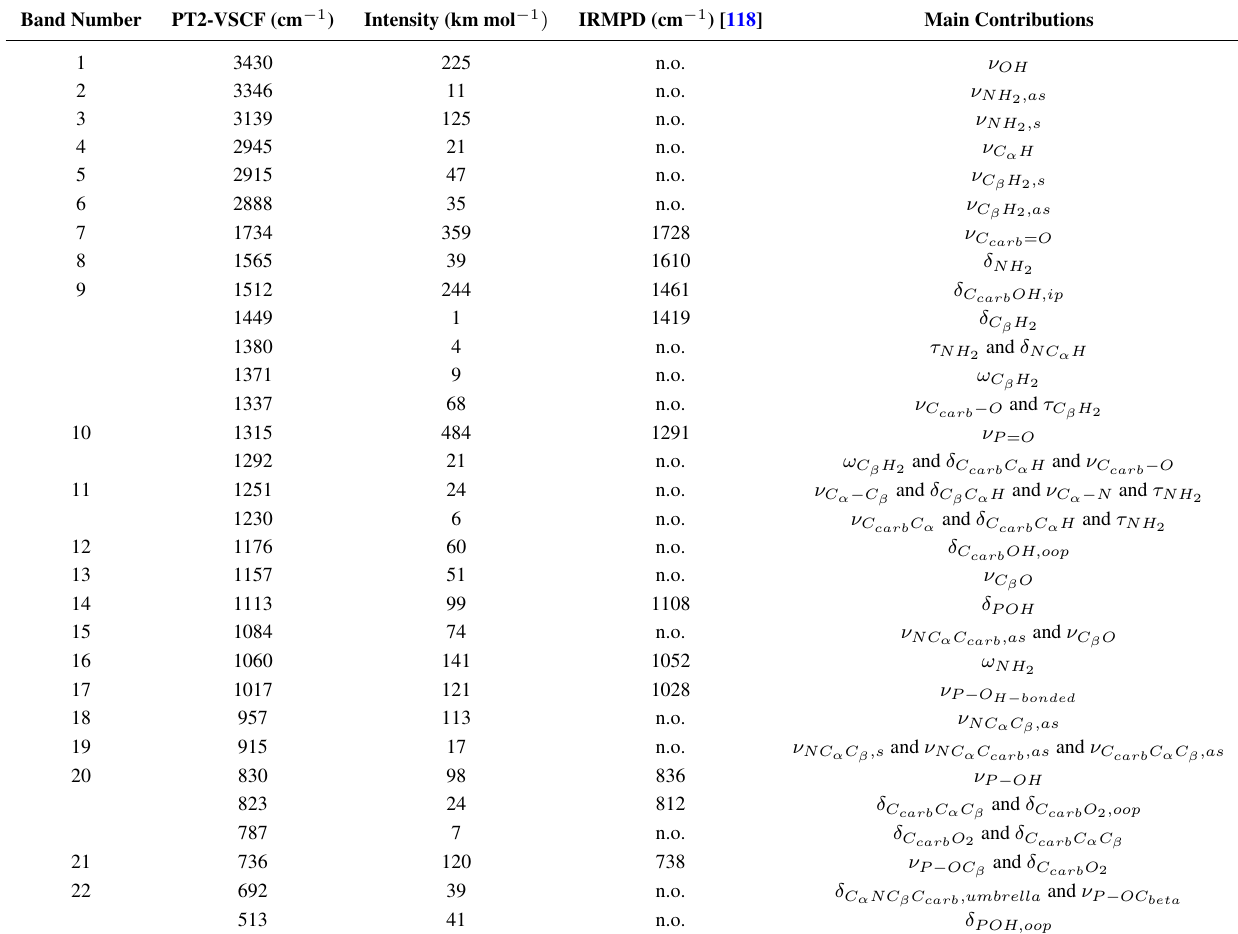
Table 4. The main absorptions of [pSer-H] − and the experimentally obtained [118] values. Band Number PT2-VSCF (cm − 1 ) Intensity (km mol − 1 ) IRMPD (cm − 1 )